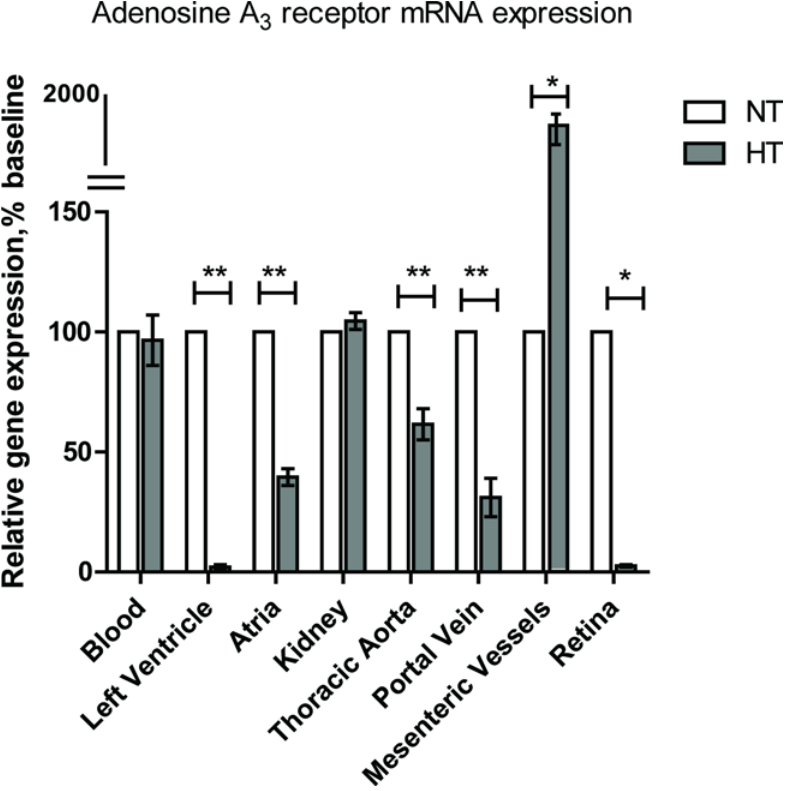
Fig 1. Relative mRNA expression of adenosine A 3 receptor in a range of cardiovascular tissues. The 2 - ΔΔ Ct method was used to calculate relative mRNA expression. A Student ’ s t test was then performed as compared spontaneously hypertensive rat group (HT) with normotensive group (NT), (n = 8 for each group). Data were presented in mean ± SEM. Three independent experiments were performed in duplicates. * p < 0.05, ** p <